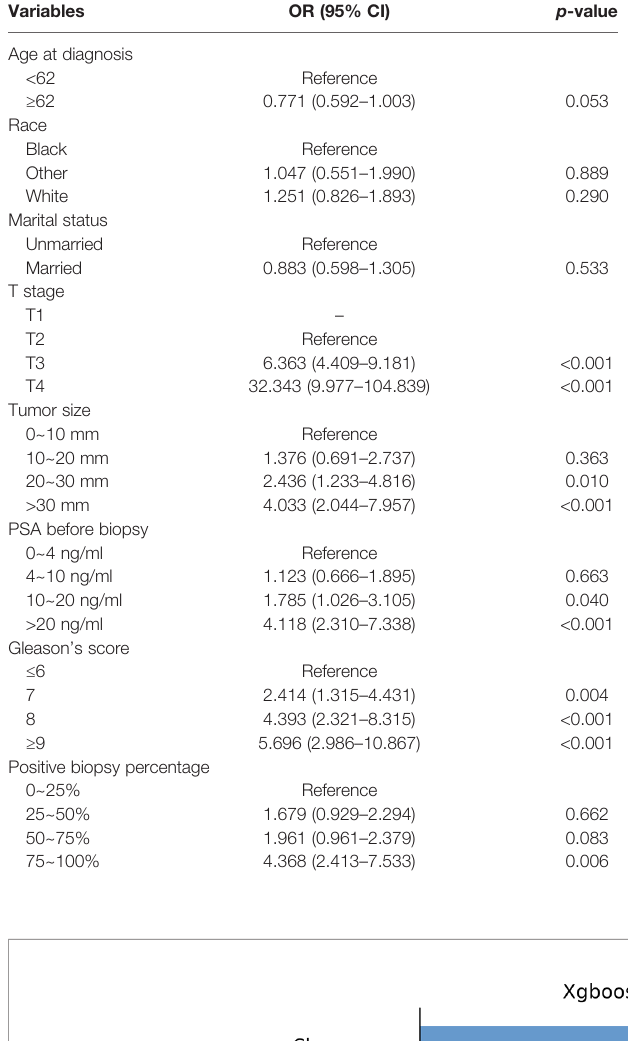
TABLE 2 | Multivariable logistic regression model with the entered variable